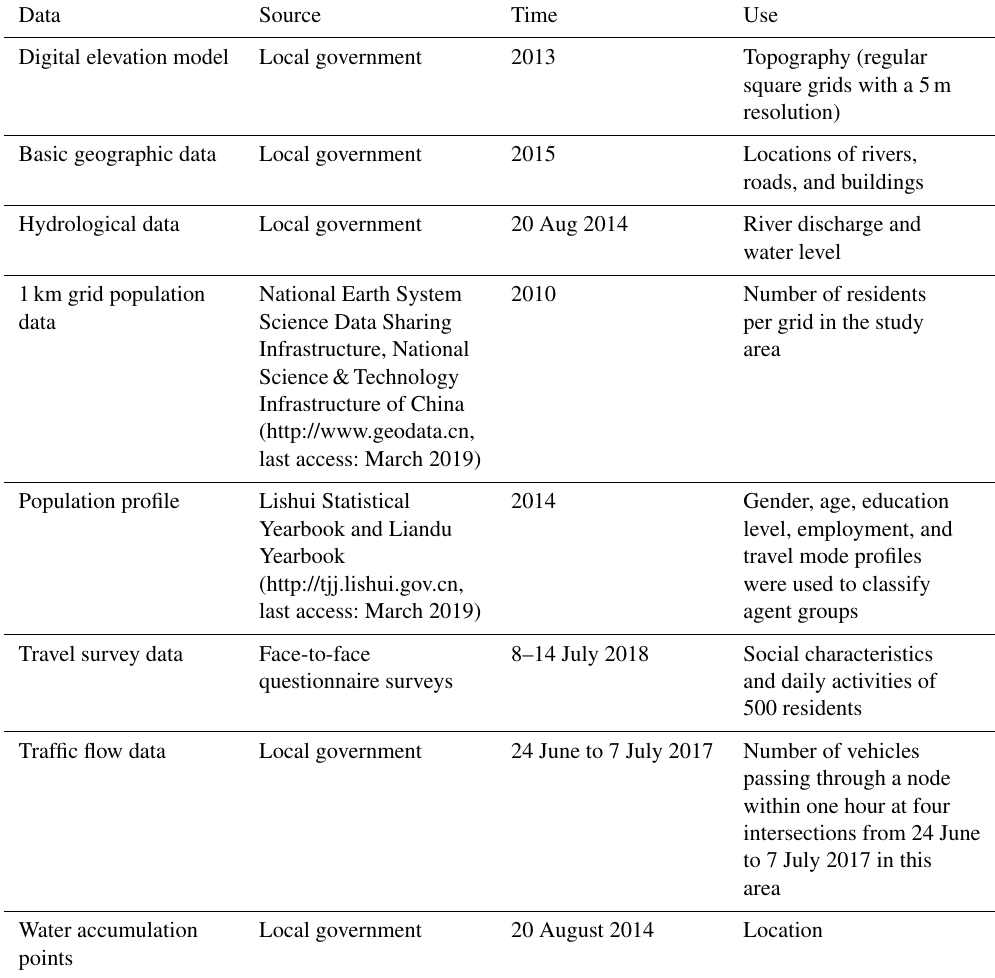
Table 1. Data used in this